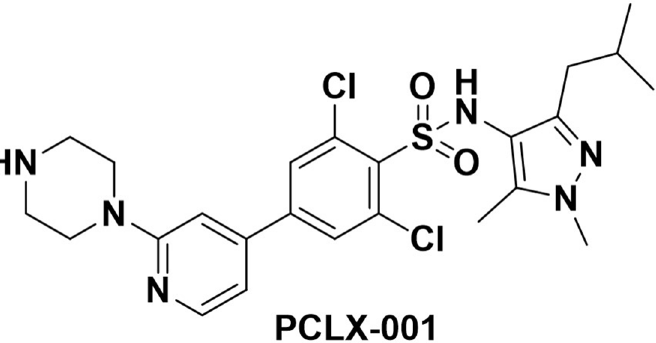
Figure 1. Chemical Structure of PCLX-001 (2,6-dichloro-N-(3-isobutyl-1,5-dimethyl-1H-pyrazol-4-yl)-4-(2- (piperazin-1-yl)pyridin-4-yl)benzenesulfonamide) C 24 H 30 Cl 2 N 6 O 2 S.